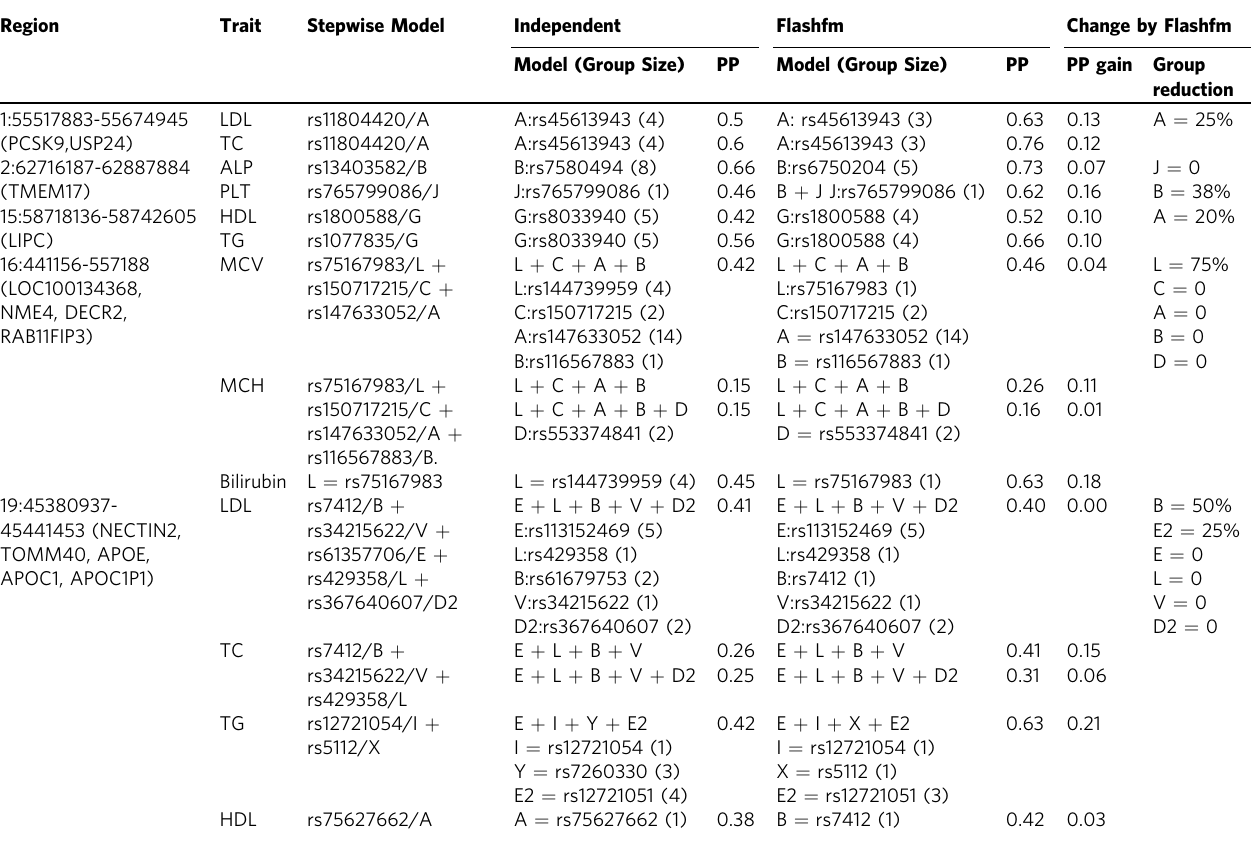
Table 6 Regions with top models chosen by stepwise (SW), independent fi ne-mapping and Flashfm where there is a noticeable reduction in SNP group sizes and/or PP of top